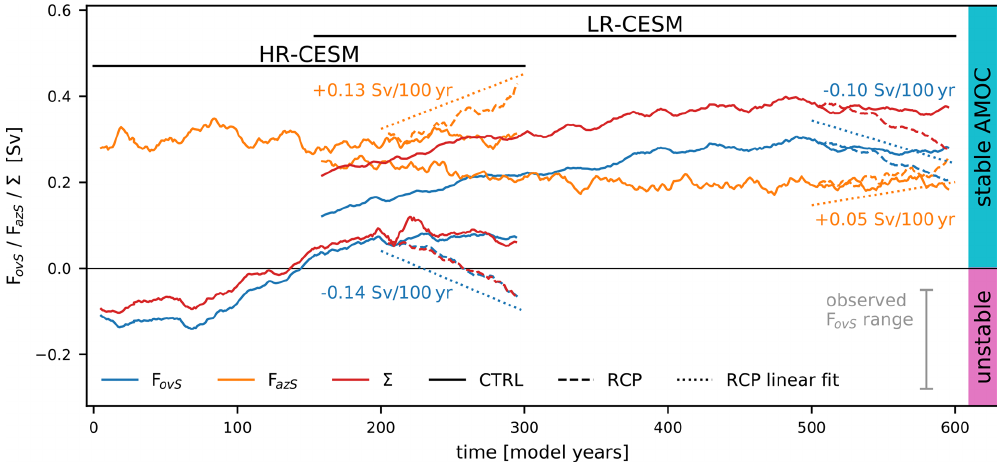
Figure 10. Time series of the annually averaged freshwater import into the Atlantic by the overturning circulation F ovS at 34 ◦ S (blue), the azonal freshwater transport contribution F az (orange), and the overturning freshwater transport divergence between 34 ◦ S and 60 ◦ N, (cid:54) (red). All available data are shown from the CTRL simulations (solid) together with the RCP simulations (dashed) branching off in year 200 (500) for HR-CESM (LR-CESM). The linear trend values of the RCP simulations are written close to offset linear fits (dotted). The observed F ovS range (gray) is from Weijer et al. (2019), and the AMOC stability regimes are labeled on the